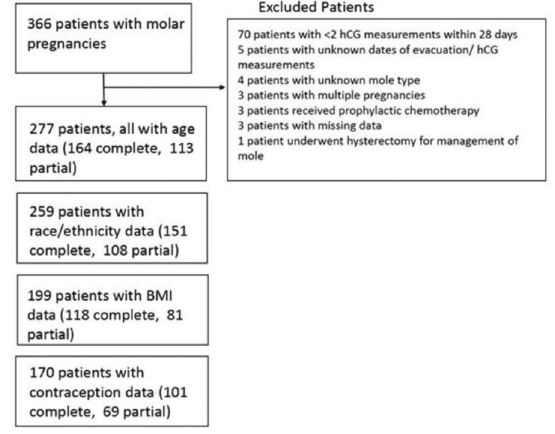
Figure 1 - Flowchart of patients with complete or partial molar pregnancies. The chart describes the excluded patients as well as the number of patients with complete and partial mole in each subgroup